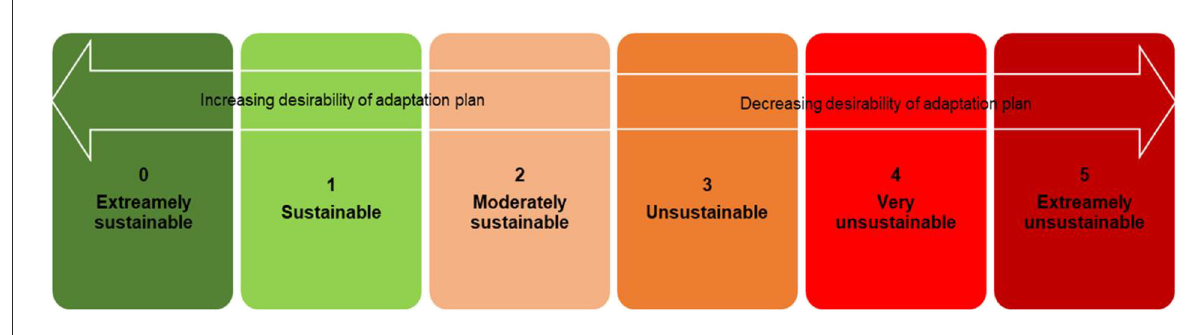
FIGURE4 Summated rating scale for adaptation cost level and sustainability of